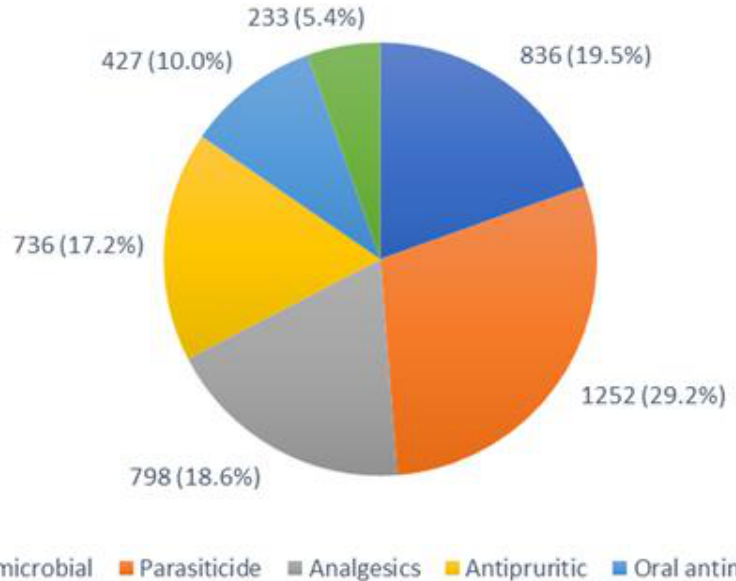
Figure 2: POM-V / POM medication classes prescribed remotely during the audit period A pie chart depicting the POM-V / POM medication classes prescribed as a result of completed remote veterinary led video consultations via a dedicated veterinary telemedicine smartphone app. between 1 April – 31 October 2020, showing the grouping into broad medication classes. 4,282 POM-V / POM medications were prescribed, from 3,541 vet-led video consultations. Medication broad classifications included oral antimicrobials, topicals containing antimicrobials, analgesics, parasiticides, antipruritics and other / miscellaneous.